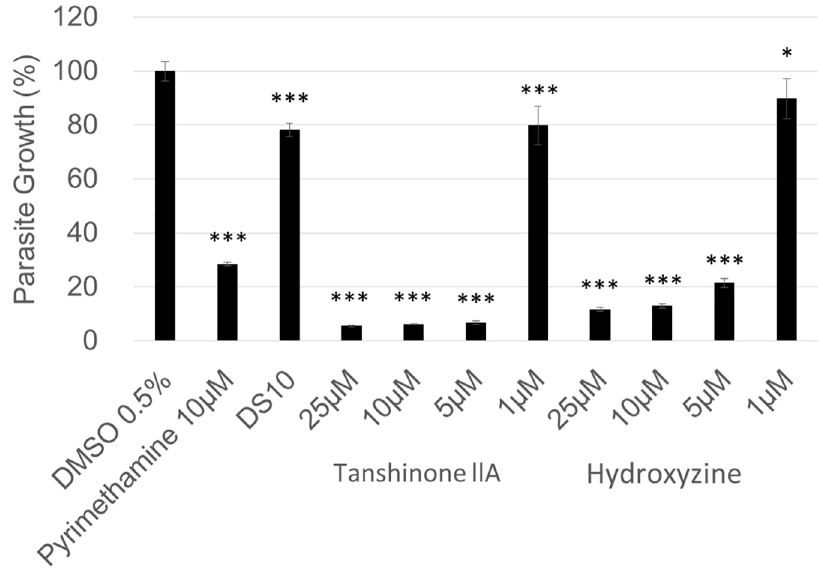
Fig 3. Evaluation of the inhibitory effects of tanshinone IIA and hydroxyzine on parasite replication after invasion. 1.0 μ M hydroxyzine, 2.5 μ M tanshinoneIIA, 10 μ M pyrimethamine, 25 mg/ml Dextran Sulfate 10 kDa fraction (DS10), or DMSO solvent control was added to parasites after washingaway uninvaded parasites at 2 h post-infection. Infected host cells were incubatedfor 48 h and β -galactosidase activity was measuredto estimate the parasite number. The DMSO control without parasite washingwas set as 100%. Means ± SD from triplicate experiments are shown. The statistical difference betweenthe DMSO control and each compoundwas evaluatedby using Dunnett’stest. * p < 0.05, *** p < 0.001.